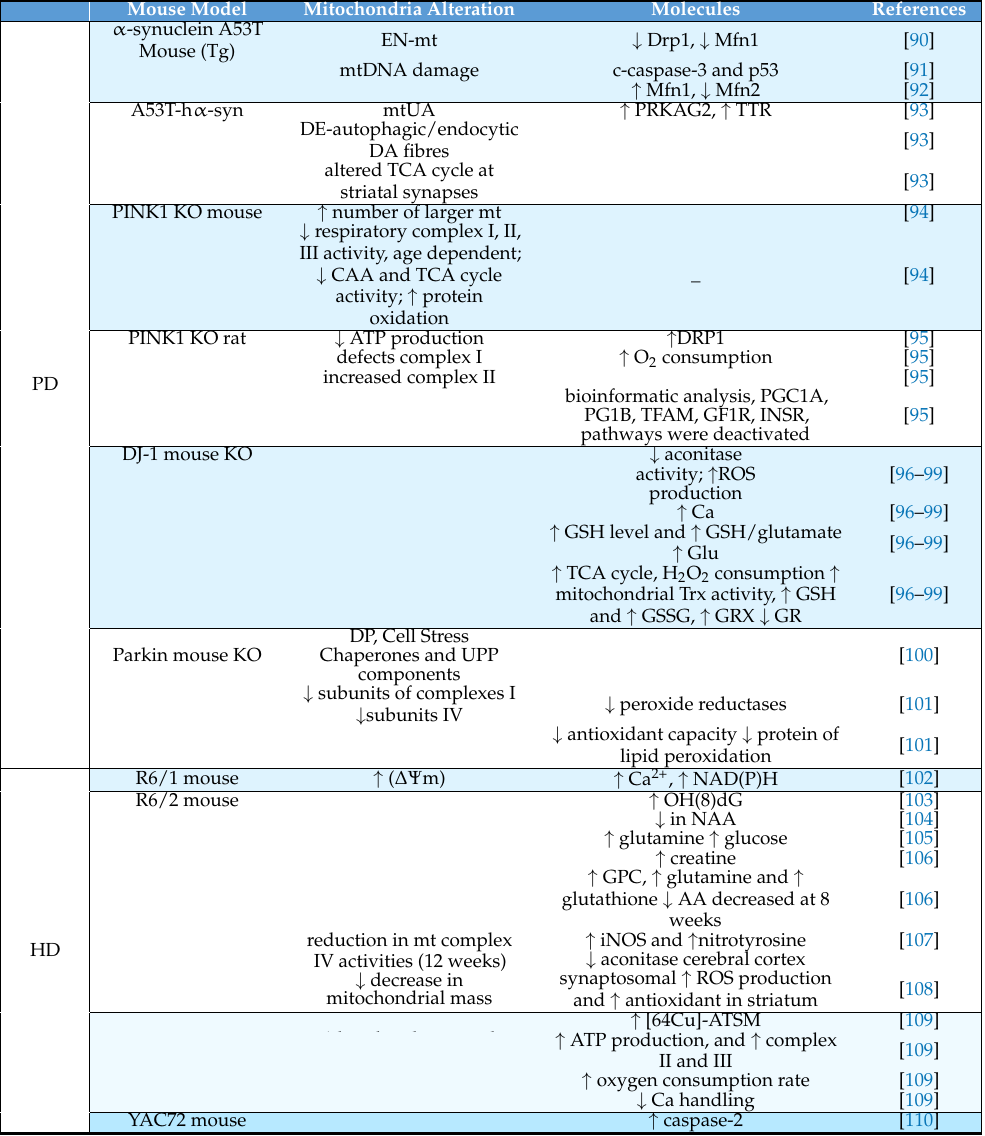
Table 1. Alteration of mitochondrial bioenergy function identified in genetic mouse models of PD and HD. The table summarizes the major mitochondrial changes found in murine models of PD and HD. The legend of the abbreviations is listed